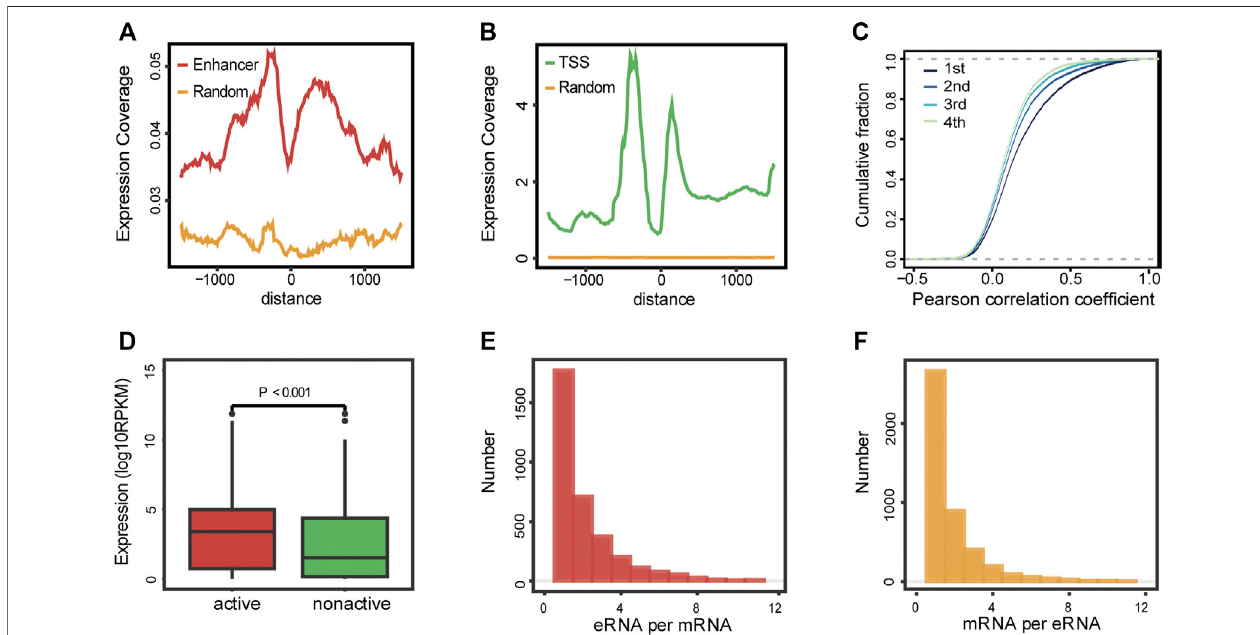
FIGURE 2| Landscapeof eRNAs in AML. (A – B) Expression coverage of enhancers (A) and protein-coding genes (B) in AML patients. TSS: transcription start site of the protein-coding gene; enhancer: enhancer loci from FANTOM5 project; and random: random loci. (C) Pairwise Pearson correlation analysis of detectable eRNAs andtheirnearbygenes.1st,theclosestgene,2nd,thesecondclosestgene,3rd,thethirdclosestgene,and4th,thefourthclosestgene. (D) Expressionlevelsofprotein- codinggenesnearactiveandnonactiveeRNAs(Wilcoxontest, p < 0.001). (E) Distributionofthenumberofprotein-codinggenesco-expressedwithpereRNA. (F) Distribution of the number of eRNAs co-expressed with per protein-coding